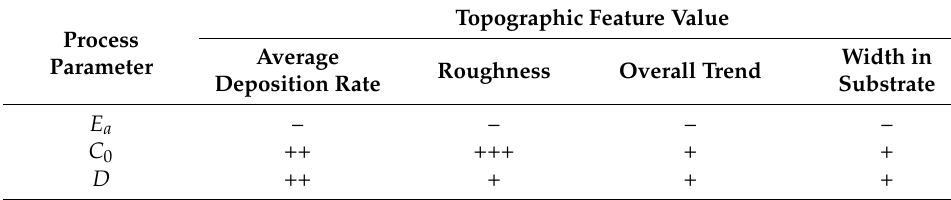
Table 4. Sediment topography control method.